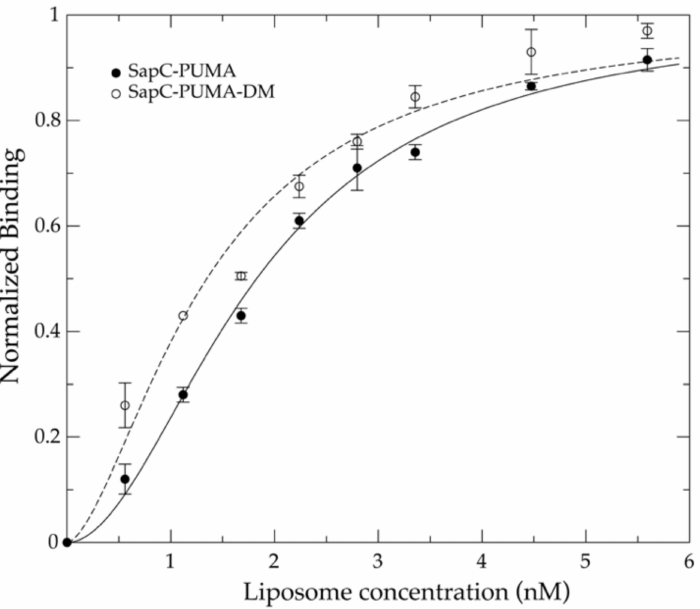
Figure 7. SapC-PUMA affinity for liposomes at pH 6 is increased by modifying the electrostatic surface of sapC: Fractional binding of sapC-PUMA and sapC-PUMA-DM to liposomes are shown in filled and open circles, respectively. Independent experiments were done twice, and the correspond- ing error bars indicate S.D. values. Liposome titrations were done using [ 1 H- 15 N]-SOFAST-HMQC experiments on 15 N-labeled sapC-PUMA and sapC-PUMA-DM samples that were mixed with in- creasing lipid concentration of PS liposomes at pH 6.0. The binding isotherms were fitted to the Hill equation as detailed in the experimental